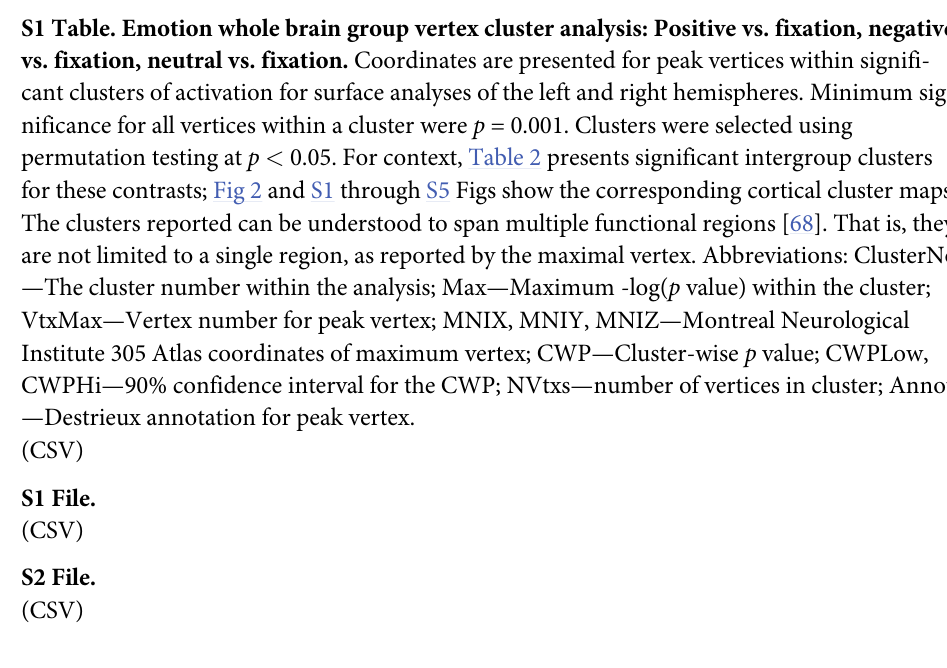
numbers were derived using permutation testing (cluster threshold p < .05, further corrected for analyses of left, right, and volume spaces). S13 Fig. Cortical surface cluster maps: Positive vs. neutral, medial. The left three columns show group maps, and the right three columns show group comparisons. The top two rows represent the left hemisphere, and the bottom two rows represent the right hemisphere. The clusters in this figure had a vertex wise threshold of p < .001 with a minimum cluster size of 100 mm 2 . This can result in more clusters being visible than are listed in Table 2, wherein numbers were derived using permutation testing (cluster threshold p < .05, further corrected for analyses of left, right, and volume spaces). S14 Fig. Cortical surface cluster maps: Negative vs. neutral, lateral. The left three columns show group maps, and the right three columns show group comparisons. The top two rows represent the left hemisphere, and the bottom two rows represent the right hemisphere. The clusters in this figure had a vertex wise threshold of p < .001 with a minimum cluster size of 100 mm 2 . This can result in more clusters being visible than are listed in Table 2, wherein numbers were derived using permutation testing (cluster threshold p < .05, further corrected for analyses of left, right, and volume spaces). S15 Fig. Cortical surface cluster maps: Negative vs. neutral, medial. The left three columns show group maps, and the right three columns show group comparisons. The top two rows represent the left hemisphere, and the bottom two rows represent the right hemisphere. The clusters in this figure had a vertex wise threshold of p < .001 with a minimum cluster size of 100 mm 2 . This can result in more clusters being visible than are listed in Table 2, wherein numbers were derived using permutation testing (cluster threshold p < .05, further corrected for analyses of left, right, and volume spaces). S1 Table. Emotion whole brain group vertex cluster analysis: Positive vs. fixation, negative vs. fixation, neutral vs. fixation. Coordinates are presented for peak vertices within signifi- cant clusters of activation for surface analyses of the left and right hemispheres. Minimum sig- nificance for all vertices within a cluster were p = 0.001. Clusters were selected using permutation testing at p < 0.05. For context, Table 2 presents significant intergroup clusters for these contrasts; Fig 2 and S1 through S5 Figs show the corresponding cortical cluster maps. The clusters reported can be understood to span multiple functional regions [68]. That is, they are not limited to a single region, as reported by the maximal vertex. Abbreviations: